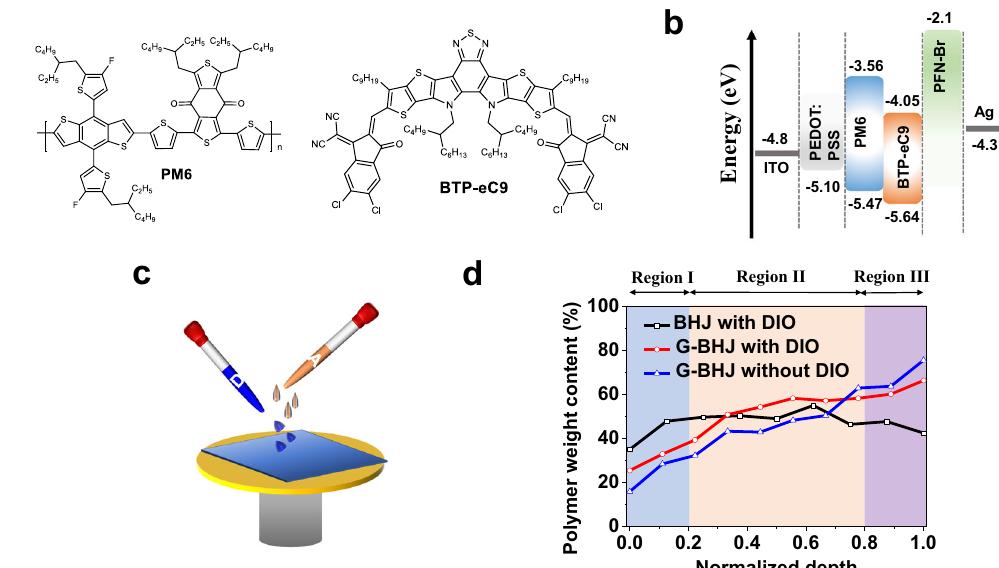
Fig. 1 Materials, optoelectronic properties and vertical composition distribution in BHJ and G-BHJ fi lms. a Chemical structure of PM6 and BTP-eC9. b Schematic illustration of the conventional device structure of OSCs. c Schematic diagram of the sequential deposition spin coating procedure. d Variation of polymer weight content of BHJ with DIO, G-BHJ without DIO and G-BHJ with DIO fi lms throughout the whole fi